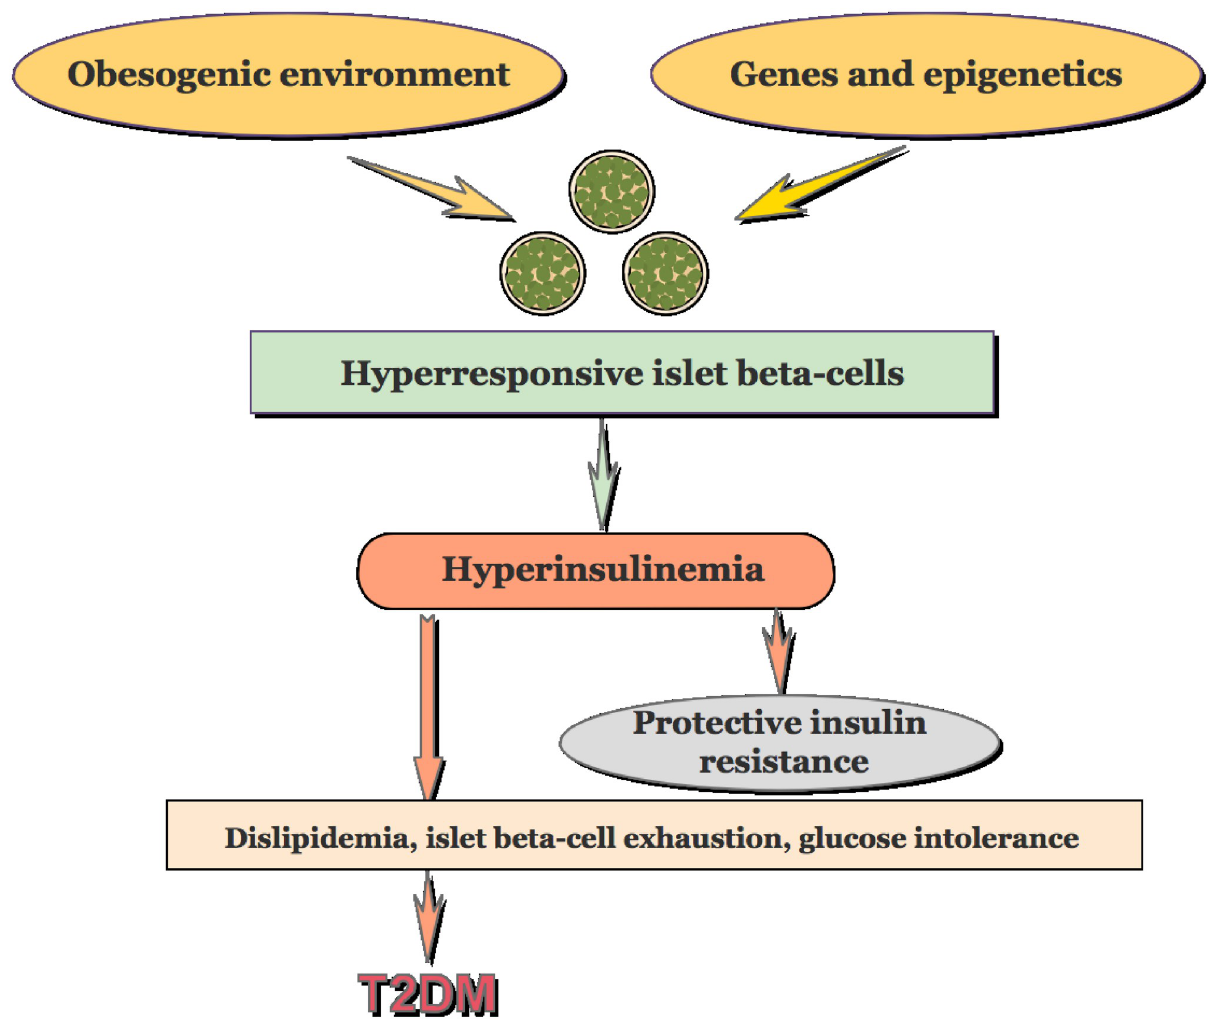
Fig 1. A conceptual framework that views insulin hypersecretion as the upstream of insulin resistance and the development of T2D. Different from the view that hyperinsulinemia is the downstream of insulin resistance, it proposes that hyperinsulinemia results from the hyperresponsive beta- cells to hostile environment, and insulin resistance is an adaptive mechanism protecting critical tissues from insulin-induced metabolic stress [13].